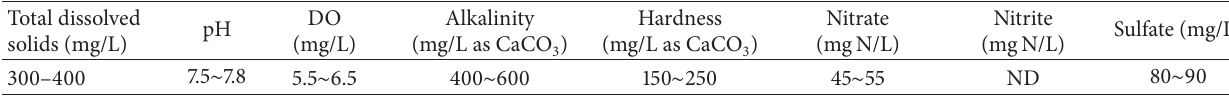
Table 1: Water quality for the groundwater.